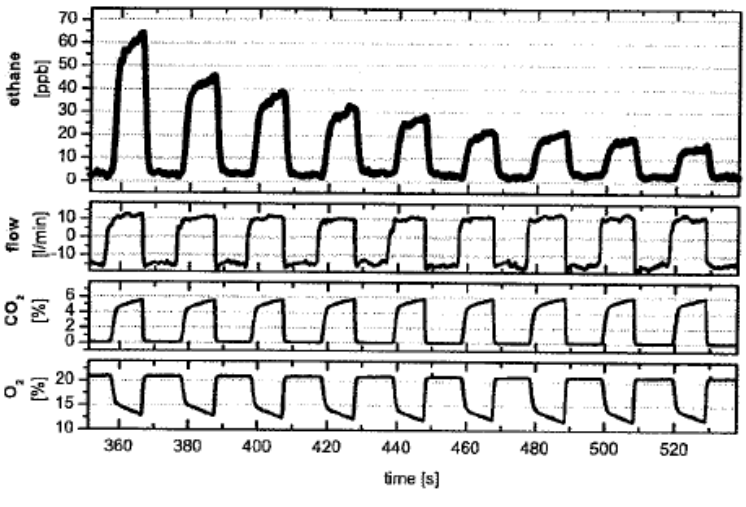
Figure 6. Typical measurement of single-breath concentrations of C Each single expiration is analyzed separately. Only 160 s are displayed in the 360–520 s time windown. The complete measurement took 42 min. (Reproduced with permission from Spinger Link